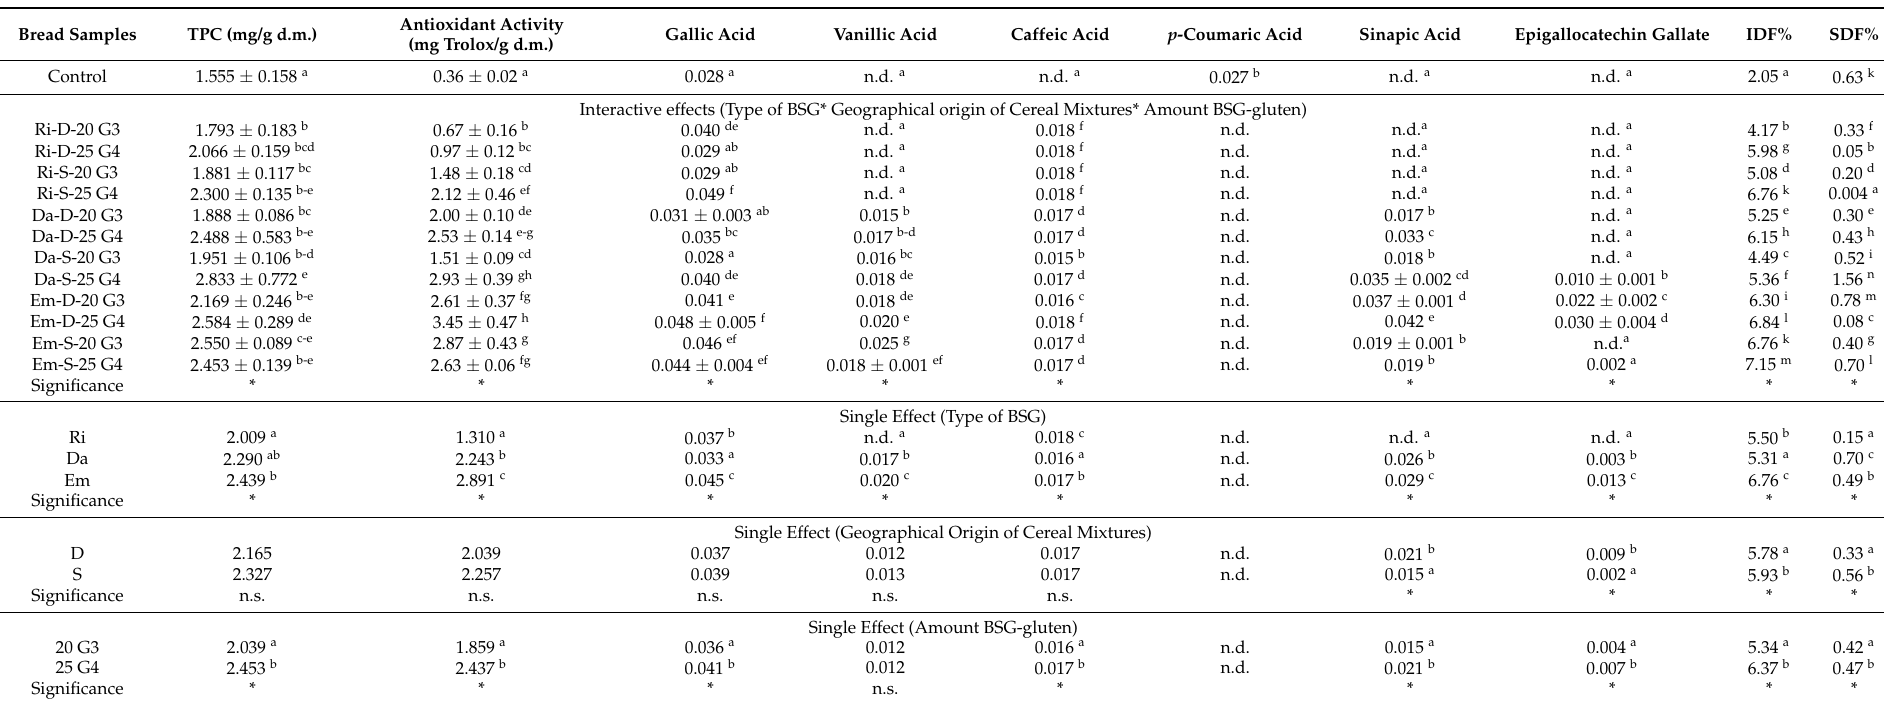
Table 6. Effects of type of BSG, geographical origin, and amounts of BSG-gluten in the formulation on antioxidant and fibre contents of the functional breads. Bread Samples TPC (mg/g